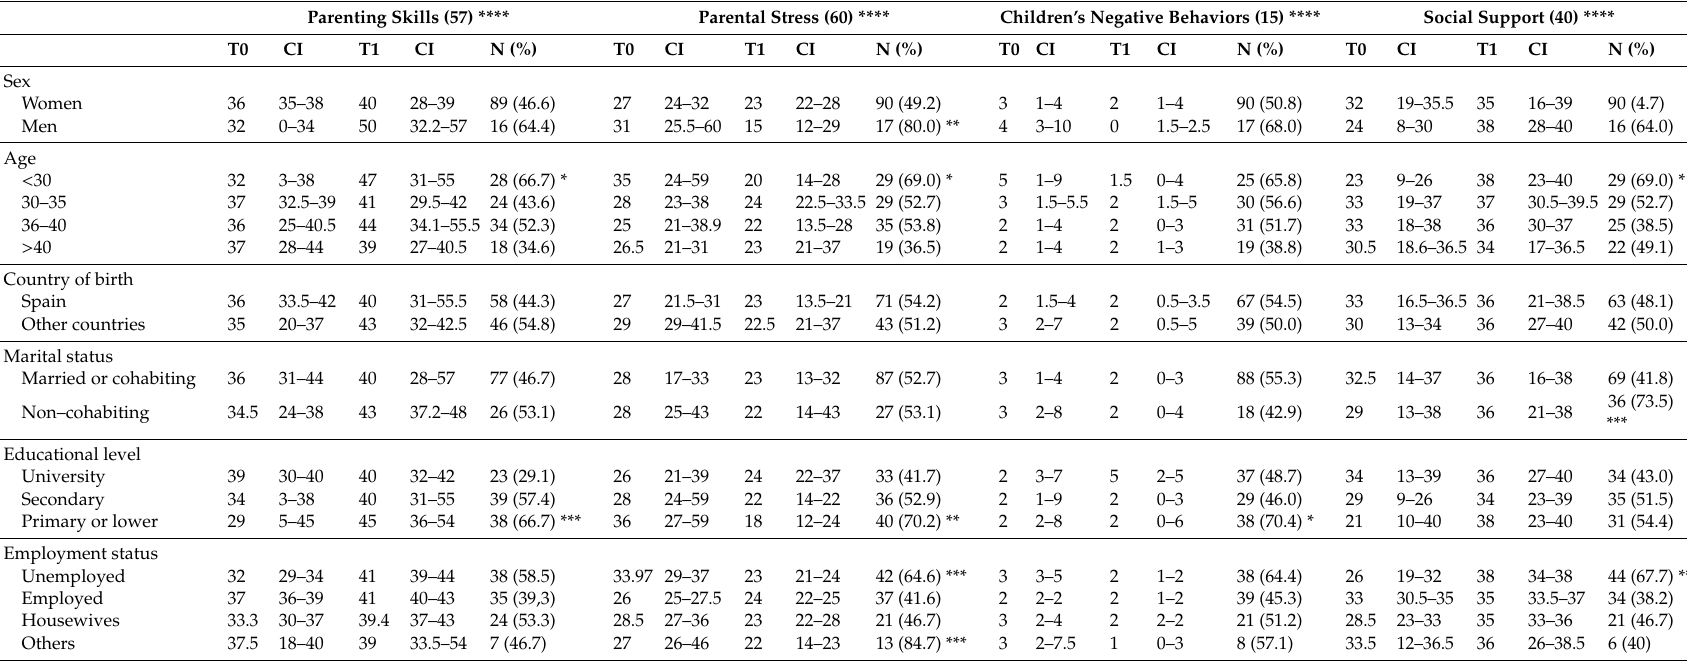
Table 2. Outcome improvement according to parents’ social factors. Bivariate